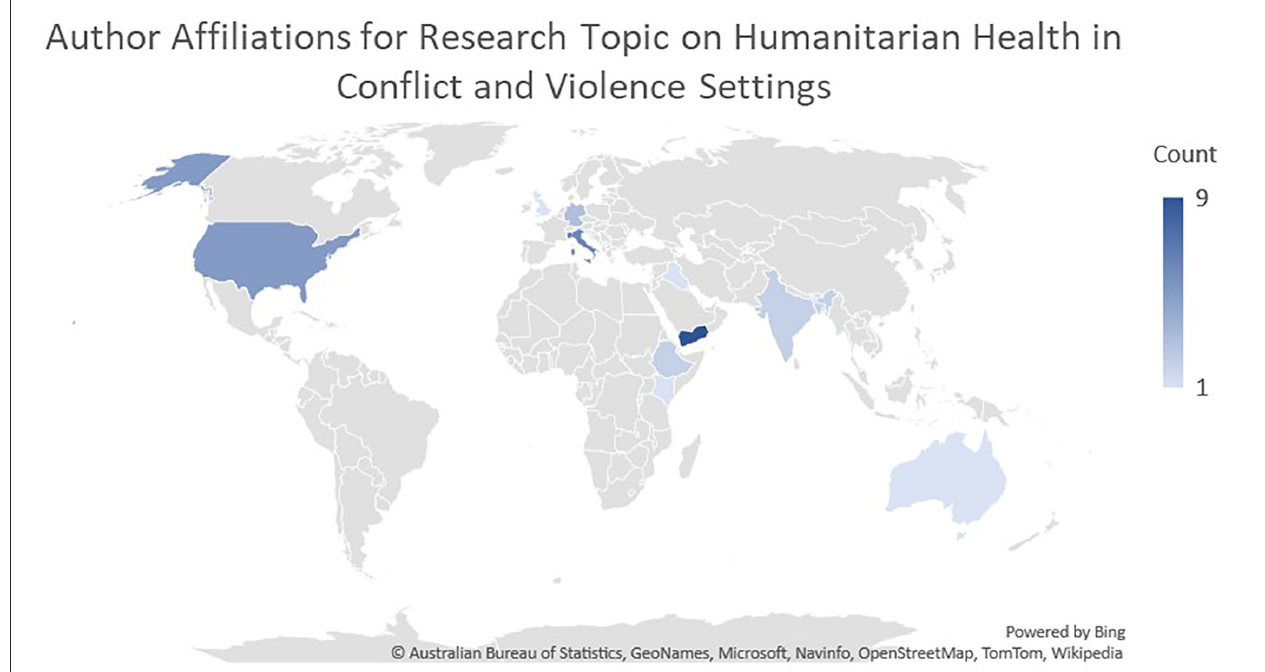
FIGURE 1 | Map showing the country affiliations of authors contributing to the Research Topic. The darkness of the color represents the number of authors listing an affiliation in that